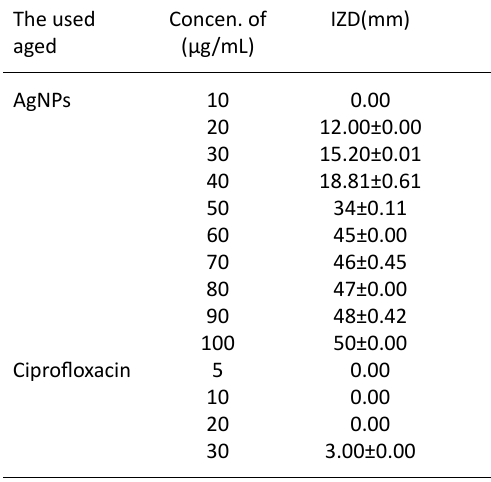
Table 2. Inhibitory activity of different concentrations of AgNPs and Ciprofloxacin against S. aureus